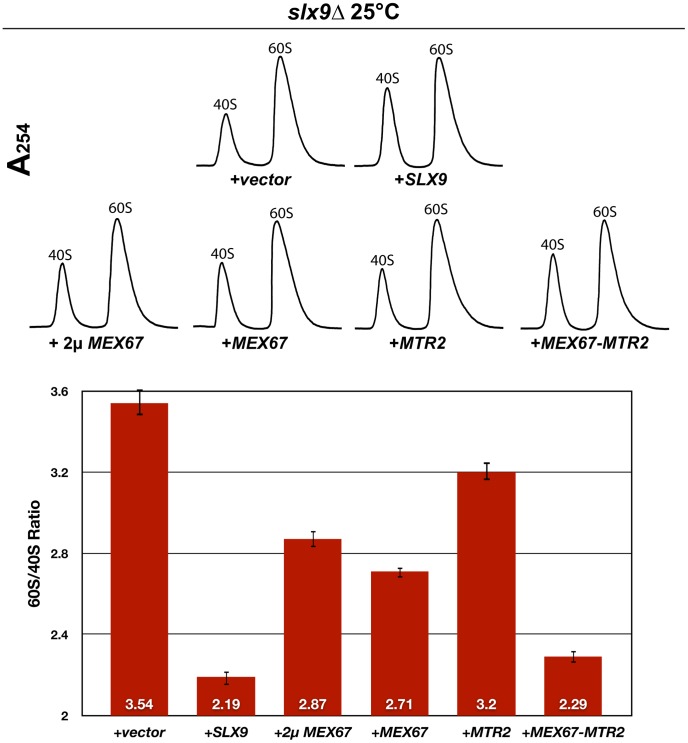
Over-expression of Mex67 and Mtr2 rescues the 60S/40S subunit imbalance of the slx9Δ mutant.The slx9Δ mutant was transformed with the indicated plasmids and grown to mid-log phase. Yeast lysates were prepared from the indicated strains in high salt conditions that dissociate the 80S and polysomes into free 40S and 60S subunits. Sucrose density gradient (7–50% sucrose) sedimentation profiles were obtained by measuring the RNA content and recorded at A254 after sedimentation centrifugation. A representative profile (3 independent replicates were performed) for each for indicated strain is shown. The 60S/40S ratio was determined and depicted by calculating the area under the A254 trace for each 60S and 40S peak using ImageJ software (version 1.42q, NIH, USA). Standard error bars are shown.